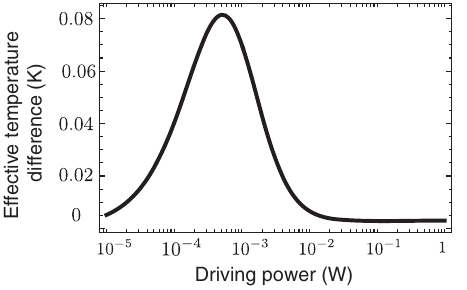
FIG. 11. Difference between the effective temperature given by the full formula Eq. (D12) and the improved approximation Eq. (D17). For this plot we have used the experimental param- eters and driving scheme corresponding to the results of Fig. 6, 295 and the bath temperature is T bath ¼